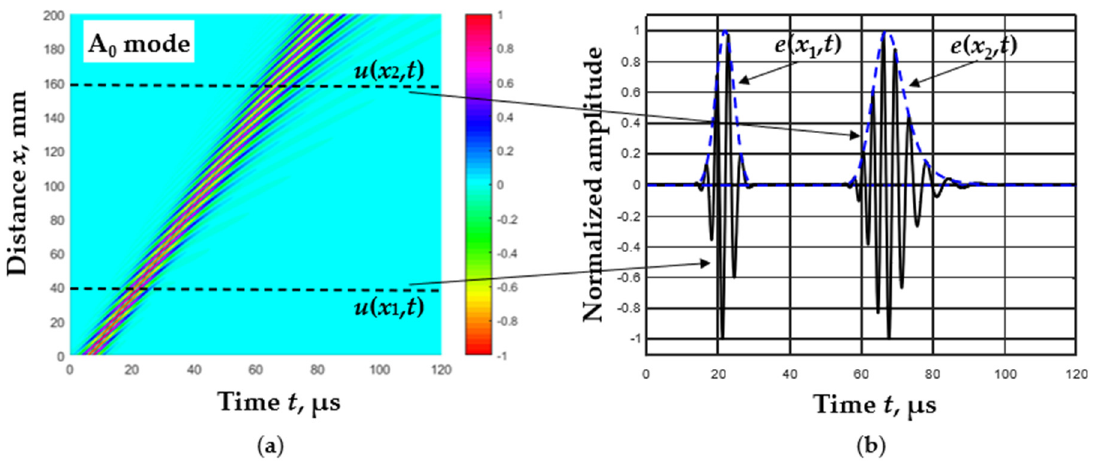
Figure 1. B-scan image of the simulated Lamb wave A 0 mode in d = 1 mm thickness aluminum plate at f ex = 300 kHz excitation frequency ( a ) and the waveforms of received signals at the distances x 1 = 40 mm and x 2 = 160 mm with its envelopes ( b ).